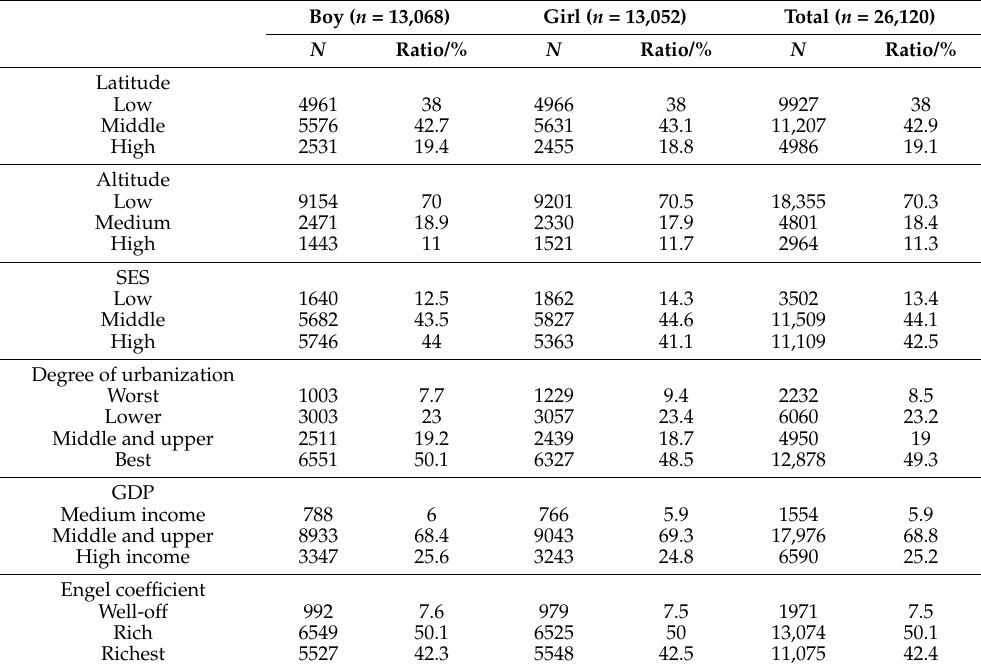
Table 1. Basic characteristics of the research